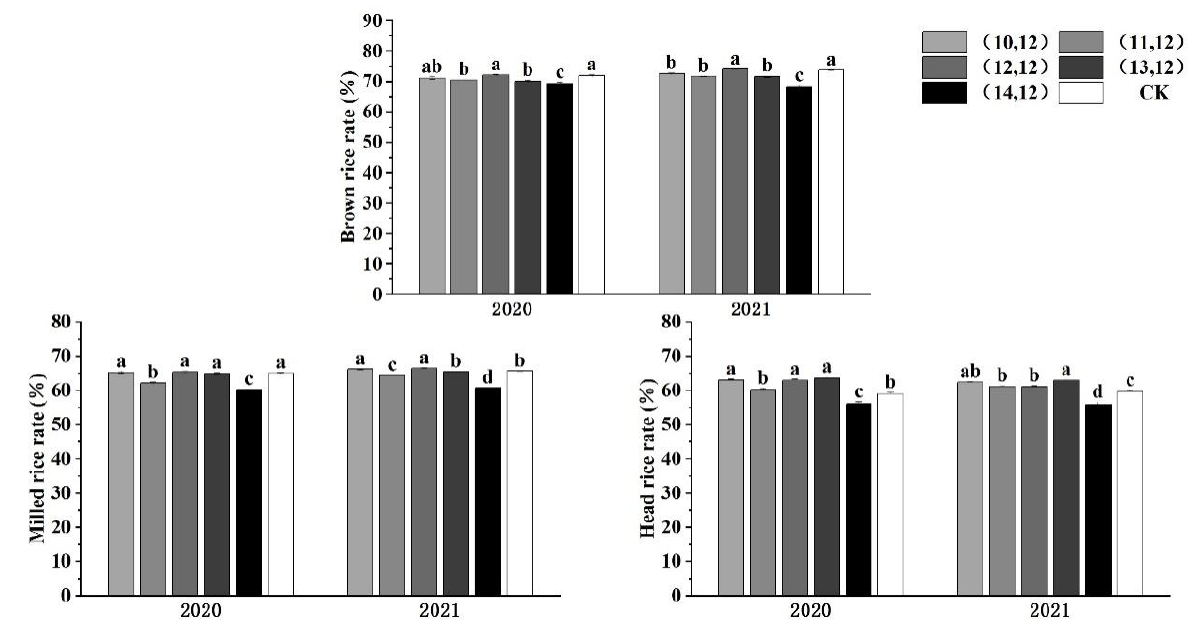
Figure 3. Effects of N and K application on rice processing quality at different leaf ages patterns in 2020 and 2021, with the results of the two-factor ANOVA. The (10,12), etc., represent the patterns of different applications of N and K at the panicle stage; CK is the fertilization pattern of local farmers. Error bars indicate standard errors of three replicates. Different lowercase letters above the columns indicate significant differences ( p < 0.05) among different panicle fertilizer application patterns in the same year. Table 3. Effects of different N and K combined application rates during the panicle stage on rice processing quality in 2020 and 2021, with the results of the three- way ANOVA.